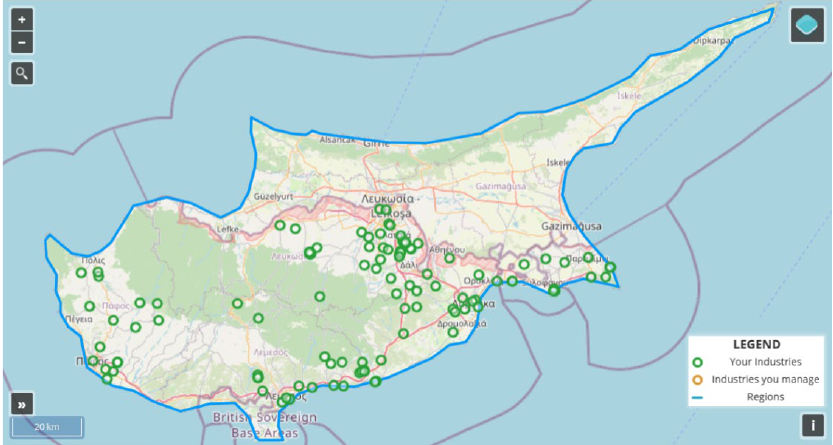
Figure 7. Map of Cypriot participants (screenshot from www.swanplatform.eu, accessed on 13 May